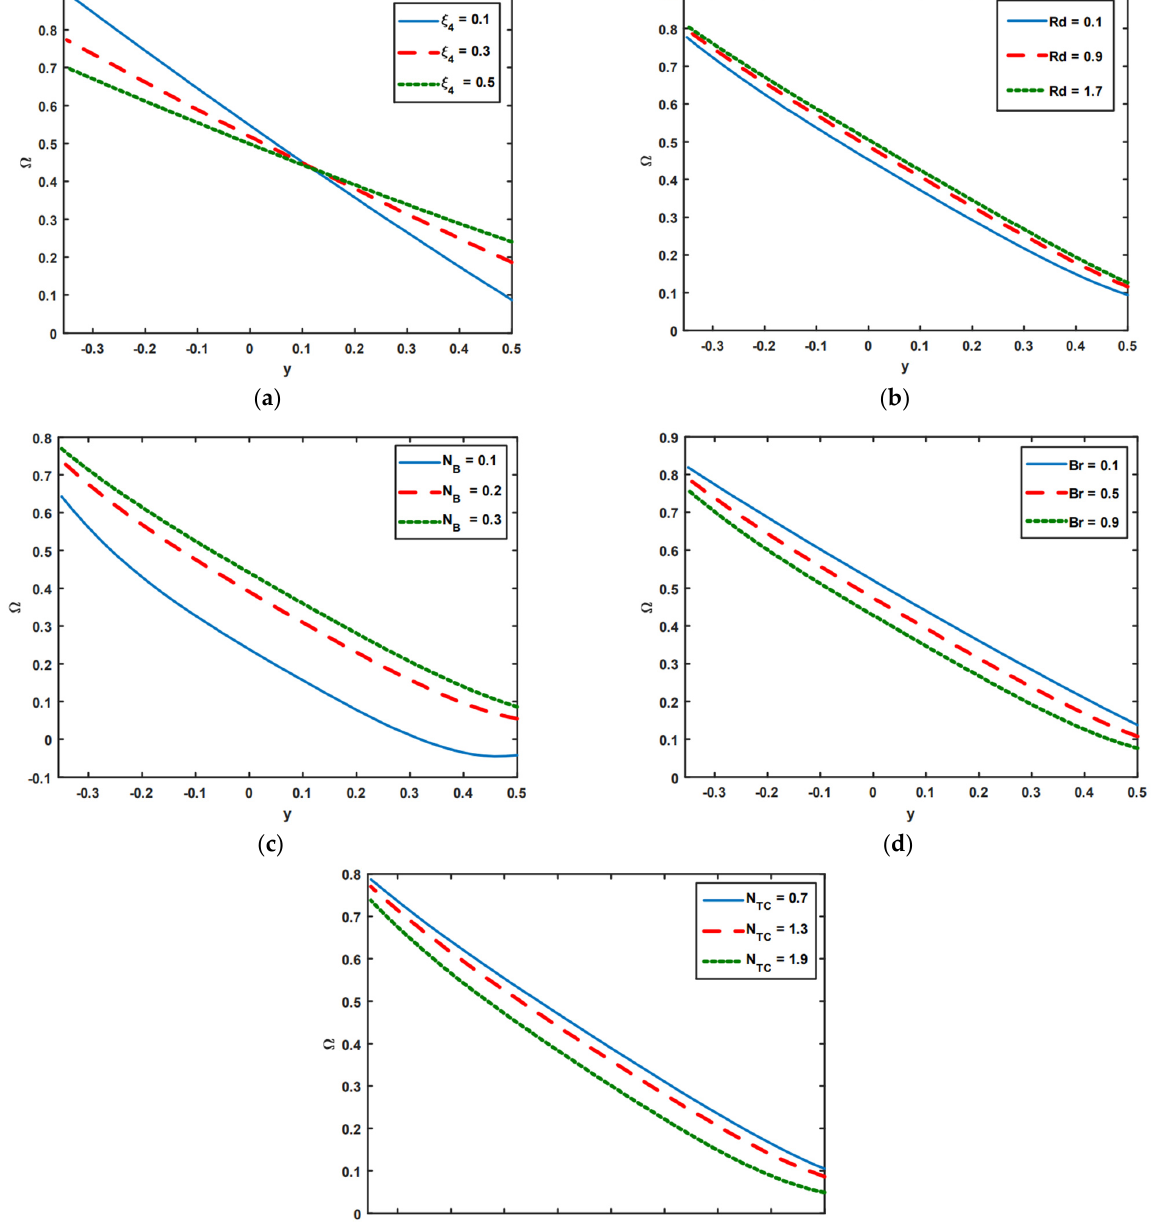
Figure 5. (a–e) Impact of 𝜉 (cid:2871) , 𝑅𝑑 , Pr, 𝑁 (cid:3029) , and 𝑁 (cid:3021)(cid:3004) on concentration profile.